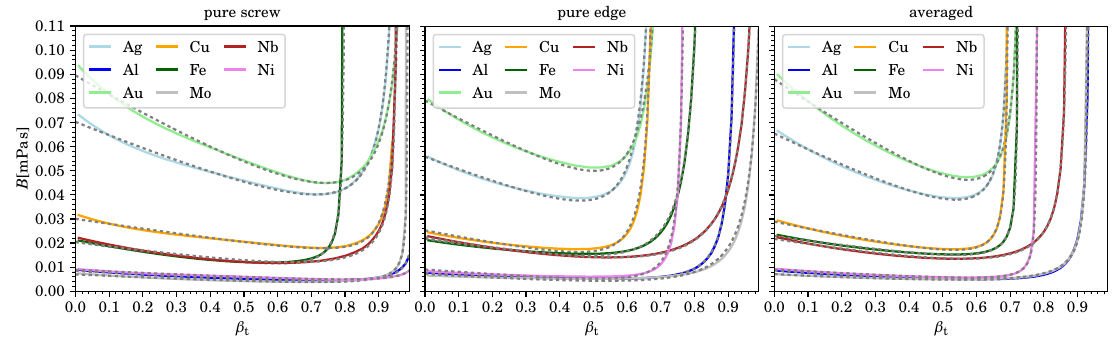
Figure 2. We show the drag coefficient B ( β T ) from phonon wind for pure screw and edge dislocations as well as B averaged over all character angles ϑ for five fcc and three bcc metals. The dashed lines represent the fitting functions and β T = v / c T .